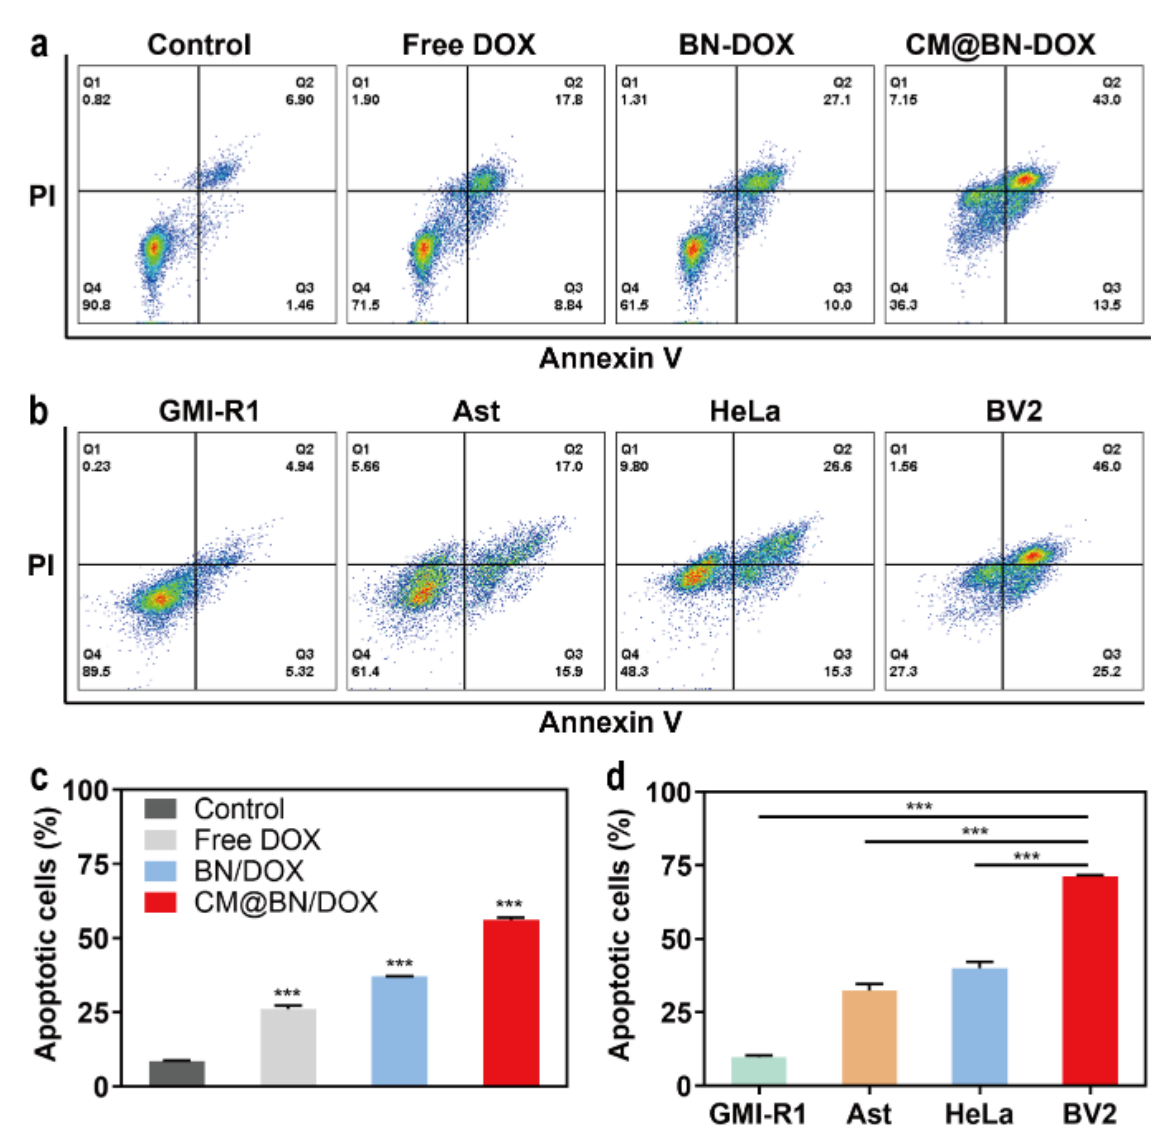
Figure 8. In vitro antitumor activity. ( a , c ) Cellular apoptosis of BV2 cells dealt with various reagents by FCM. ( b , d ) Cellular apoptosis of BV2, HeLa, GMI-R1, and Ast cells treated with CM@BN/DOX by FCM. Data are expressed as means ± SD, *** p < 0.001.